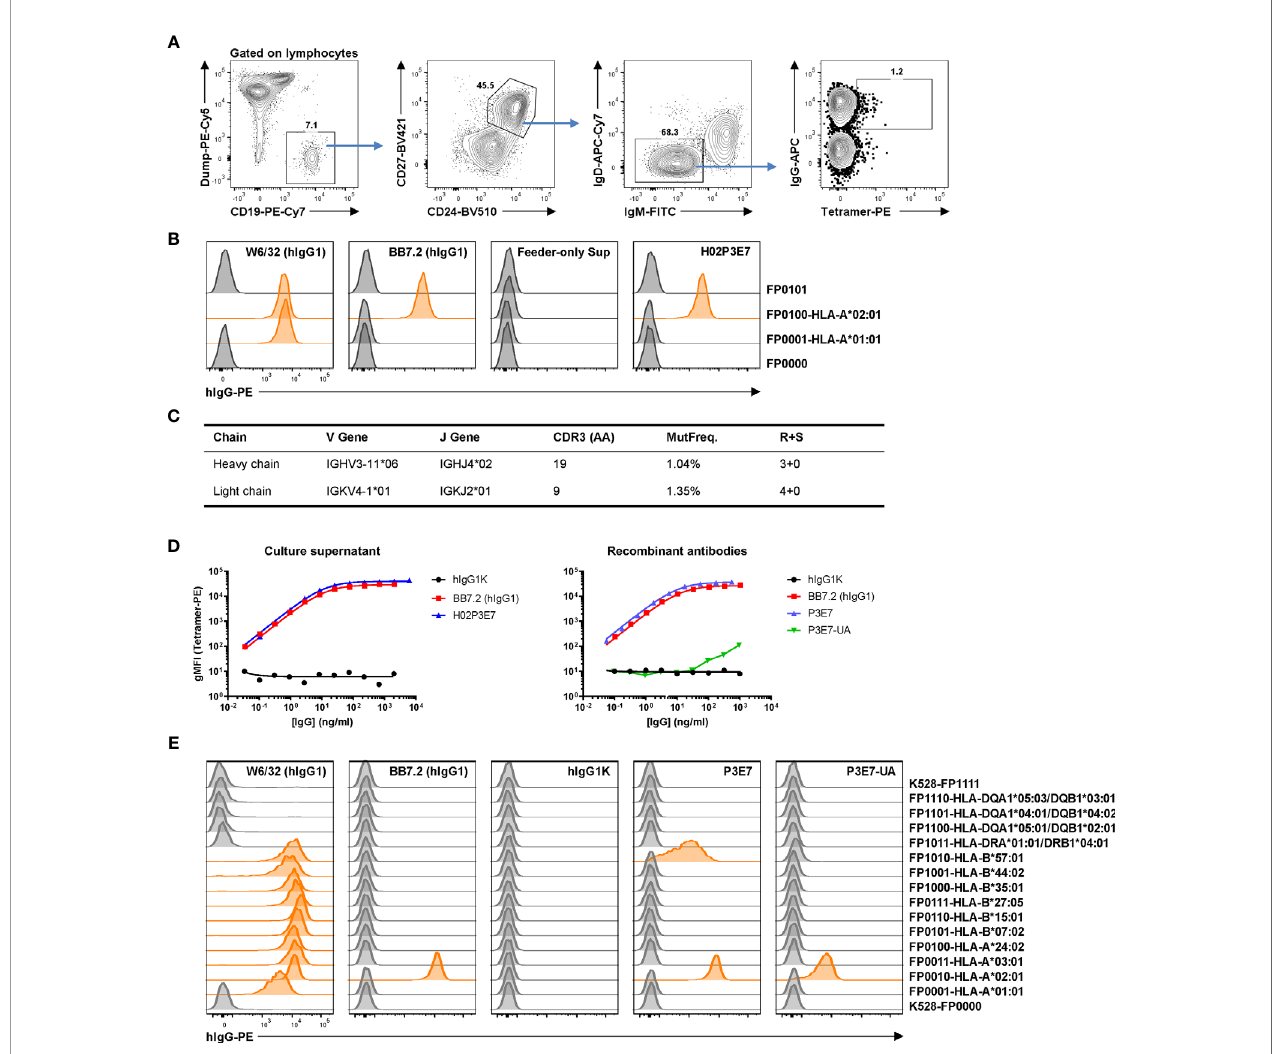
FIGURE 4 | Identi fi cation and characterization of an anti-allo HLA Bmem cell clone from a sensitized patient. (A) Gating strategy for antigen-speci fi c single B-cell sorting. Frozen-thawed PBMCs from an allo-sensitized patient was stained with HLA-A*02:01 tetramer and surface markers to identify tetramer-binding IgG + Bmem cells for single B-cell culture. Dump, CD3/CD14/CD16/7-AAD. After 25 days culture, IgG + supernatants were subjected to a reporter cell assay to screen for HLA- binding clones. (B) Example data of reporter cell assay with positive control antibodies, a negative control (feeder-only) supernatant and supernatant from the single HLA-A*02:01-binding clone H02P3E7 identi fi ed. In this experiment, two HLA-expressing and two control reporter cell lines were used. W6/32, pan class I HLA speci fi c; BB7.2, HLA-A*02-speci fi c. (C) Genetics of the BCR of the identi fi ed clone H02P3E7. MutFreq, nucleotide mutation frequency of V genes. R+S, replacement and silent mutations. (D) Binding activities of the culture supernatant (left panel) from Bmem clone H02P3E7 and rAbs (right panel) from identi fi ed clone (P3E7) and inferred germline clone (P3E7-UA) to HLA-A*02:01 tetramer antigen. hIgG1K, human IgG1 kappa isotype control antibody. (E) Reporter cell assay with control antibodies and rAbs P3E7 and P3E7-UA. Demultiplexed reporter cell lines with MFI values above three-fold of the average MFI value of internal control cell lines (K528-FP0000 and K528-FP1111) were scored as positive and the histograms were highlighted in